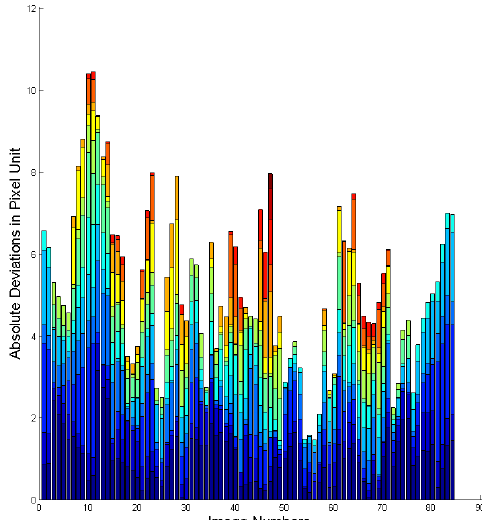
Figure 6. Absolute deviations of the estimated image targets and image targets measurements in pixel unit